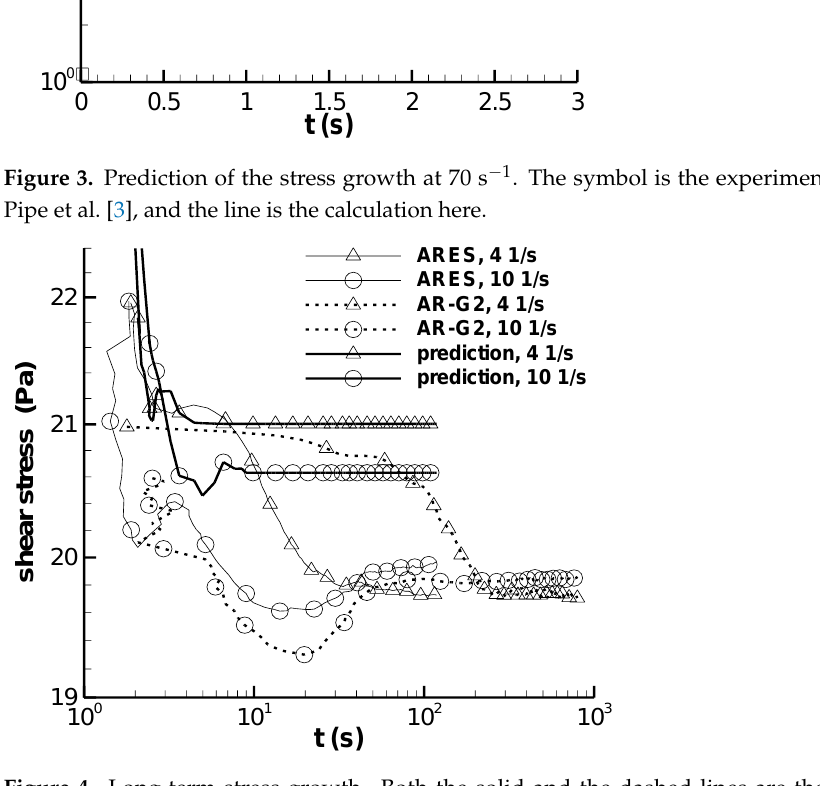
Figure 4. Long-term stress growth. Both the solid and the dashed lines are the experiments in Figure 10 of Pipe et al. [3], and the bold solid line is the calculation here.